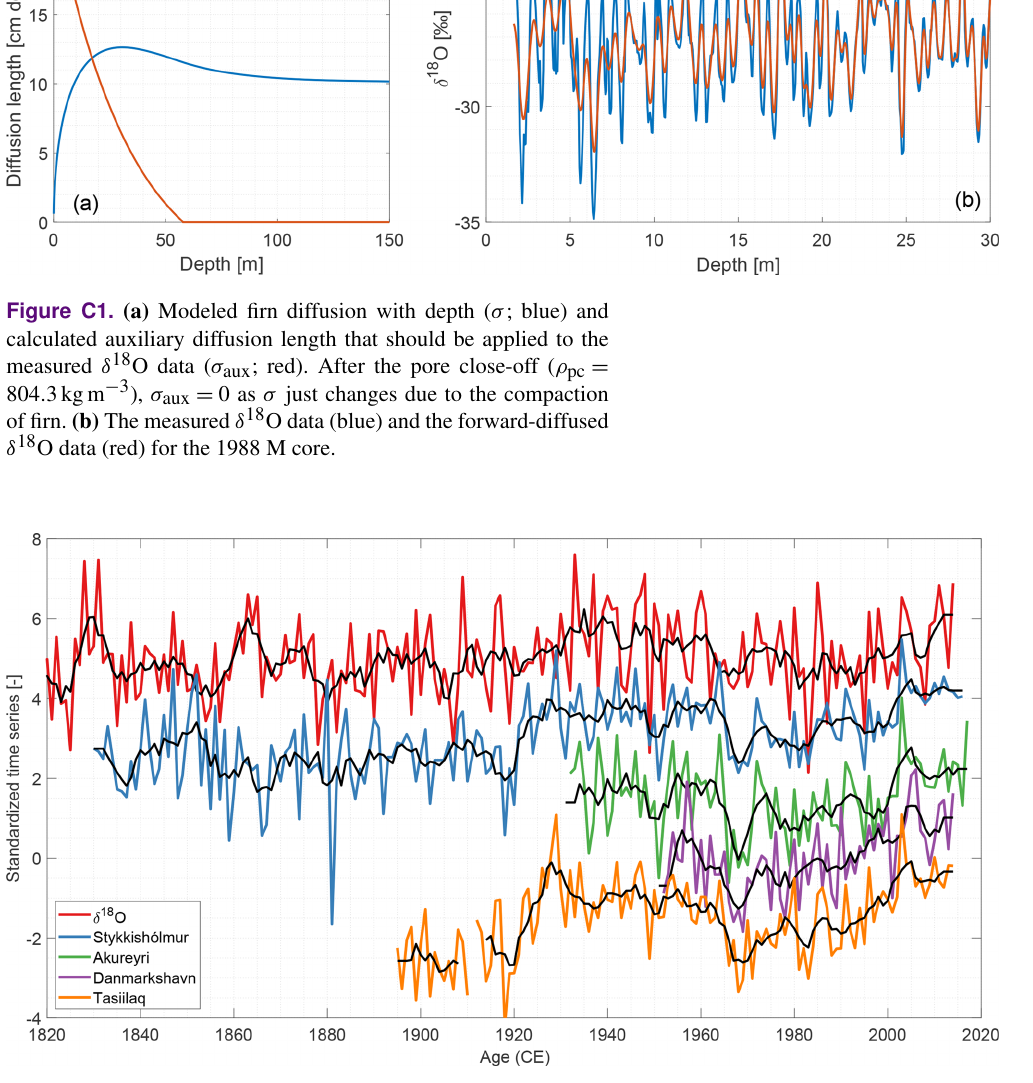
Figure C2. Winter-averaged δ 18 O and temperature series. For vi- sualization, the time series have been standardized and shifted ver- tically. The black curves represent a moving average of 5